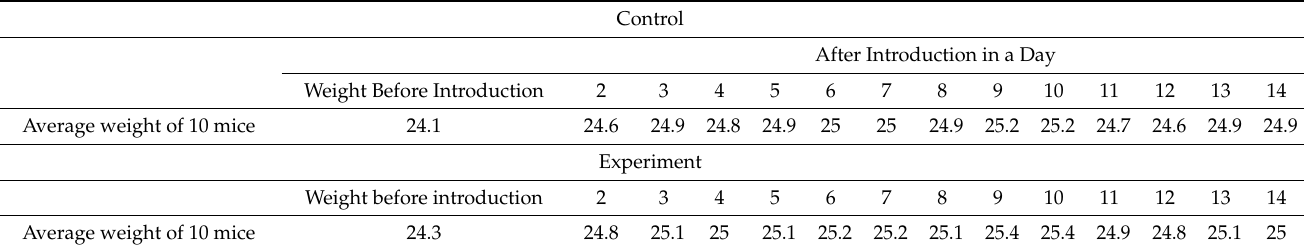
Table 4. Body weight of mice (g) with the introduction of the filtrate into the stomach (average values of 10 experimental individuals are indicated).